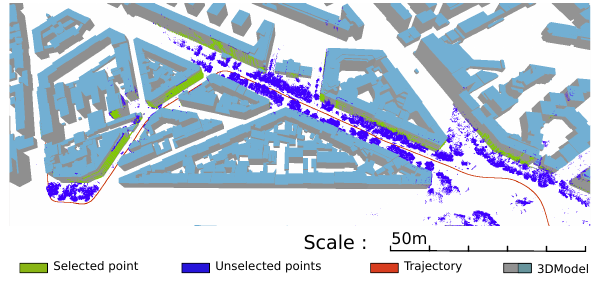
Figure 7: Overview of the geometric descriptor.